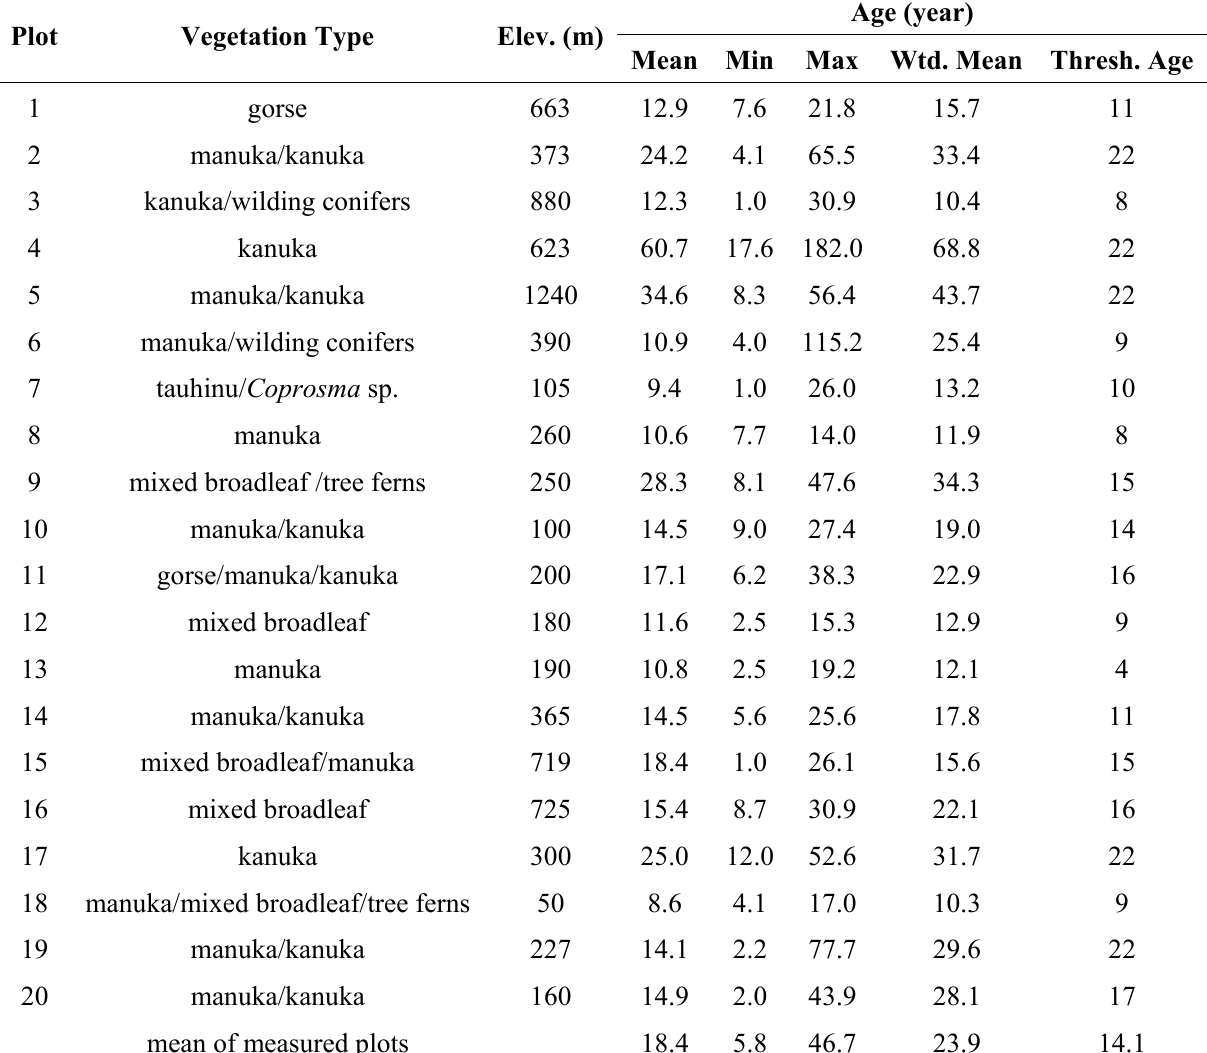
Table 2. Plot vegetation type, site elevation (“Elev.”), mean, minimum and maximum age of stems, mean age of stems weighted by aboveground biomass (AGB) carbon (“Wtd. Mean”) and years (“Thresh. Age”) since AGB carbon exceeded a threshold of 2 t/ha.